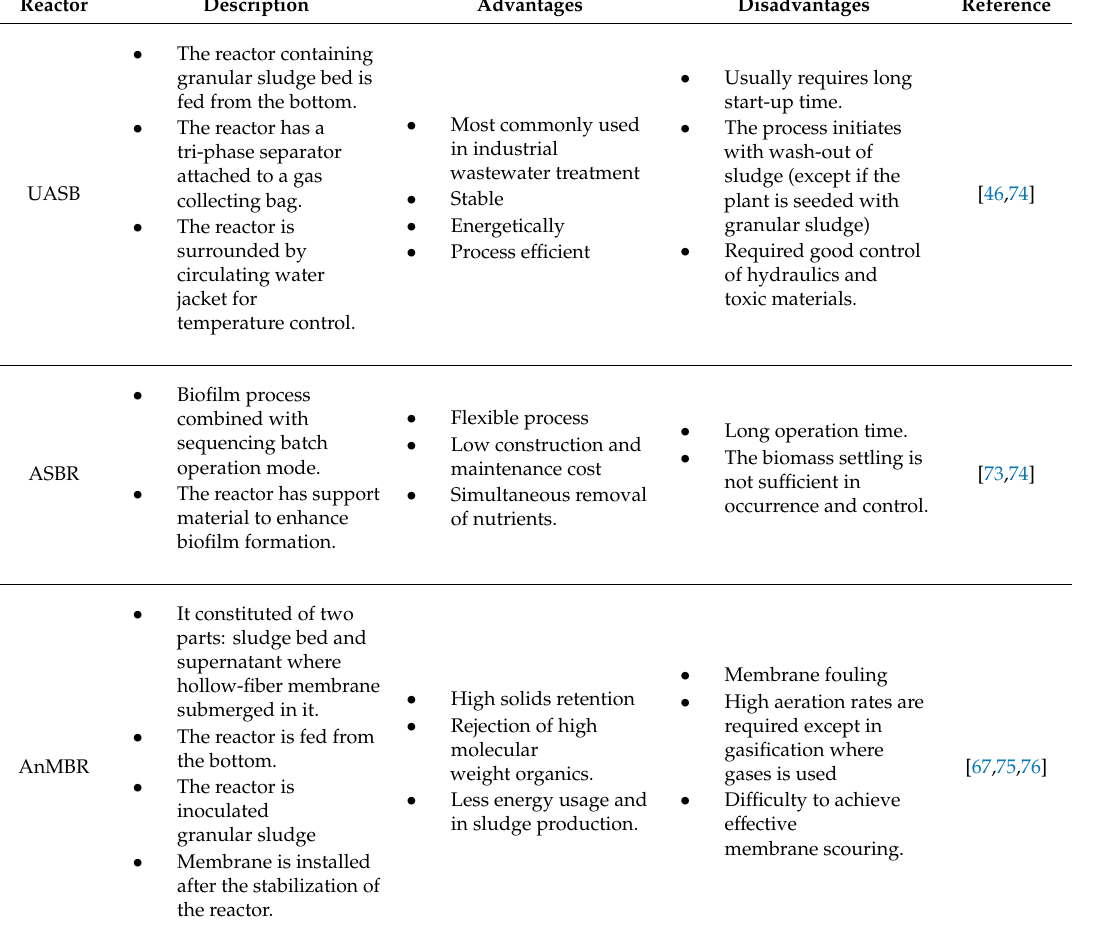
Table 3. Commonly used anaerobic reactors with their advantages and